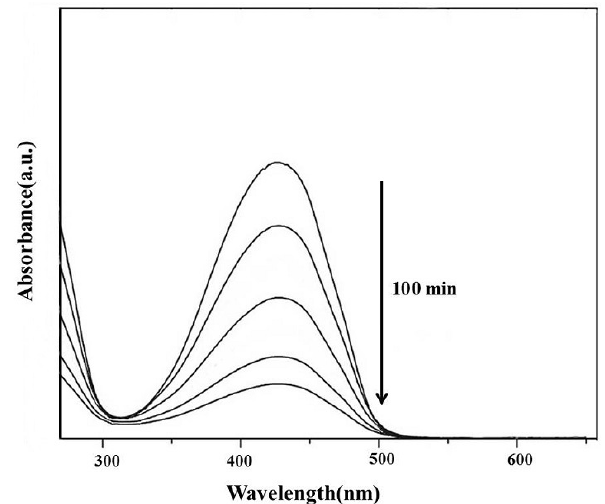
Fig. 7. Adsorption and degradation of Yellow 5 under visible light irradiation using Yb 0.06 Zn 0.94 S